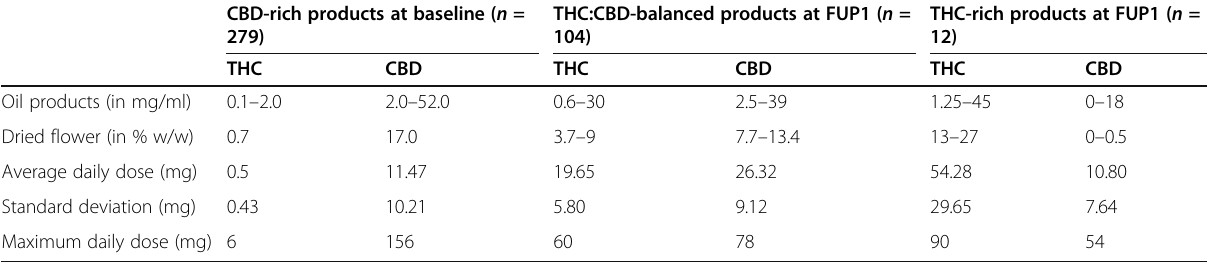
Table 3 Details of the THC and CBD component of the CBD-rich, the THC:CBD 1:1, and the THC-rich formulations CBD-rich products at baseline ( n = 279)